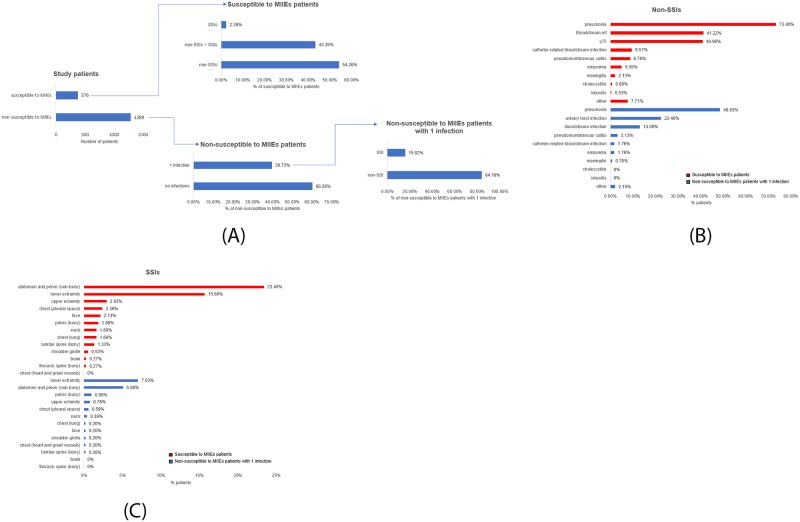
Characterization of the infections.A. Out of the 376 susceptible to MIIEs patients, 54.26% (n = 204) presented with non-surgical-site infections (non-SSIs) alone, 2.39% (n = 9) presented with surgical site infections (SSIs) alone, while 43.35% (n = 163) presented with both non-SSIs and SSIs. From the 1289 non-susceptible to MIIEs patients, 60.28% (n = 777) exhibited no infections and 39.72% (512) suffered 1 infection. Out of the 512 non-susceptible to MIIEs patients that presented with 1 infection, 84.18% (n = 431) suffered a non-surgical-site infection (non-SSI), while 15.82% (n = 81) suffered a surgical site infection (SSI). B. Characterization of the types of non-SSIs among susceptible to MIIEs patients (red bars) and non-susceptible to MIIEs patients with 1 infection (blue bars). C. Characterization of the location of SSIs among susceptible to MIIEs patients (red bars) and non-susceptible to MIIEs patients with 1 infection (blue bars).